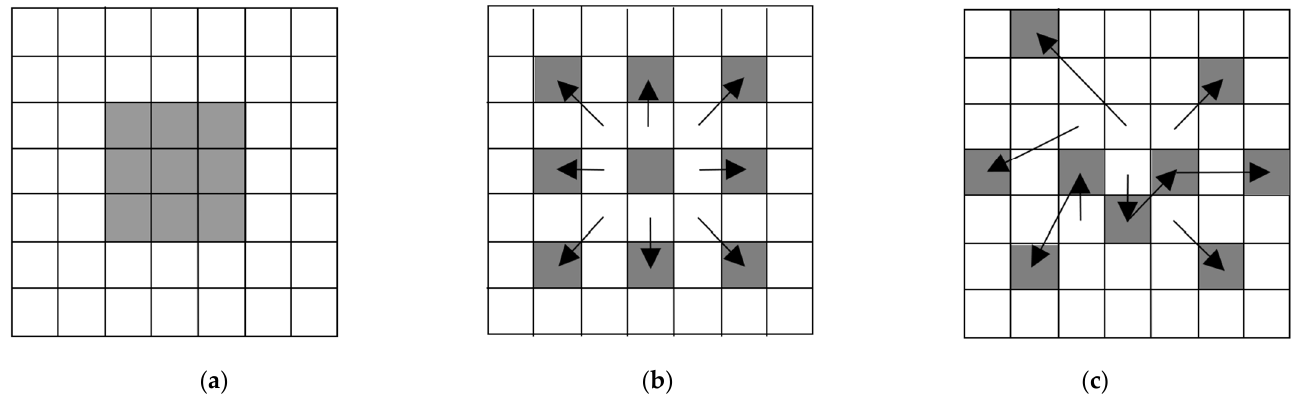
Figure 3. Examples of various convolution operations where the kernel is marked as gray pixels and its size is 3 × 3. ( a ) Conventional convolution. ( b ) Dilated convolution with dilation factor 2. ( c ) Deformable convolution.